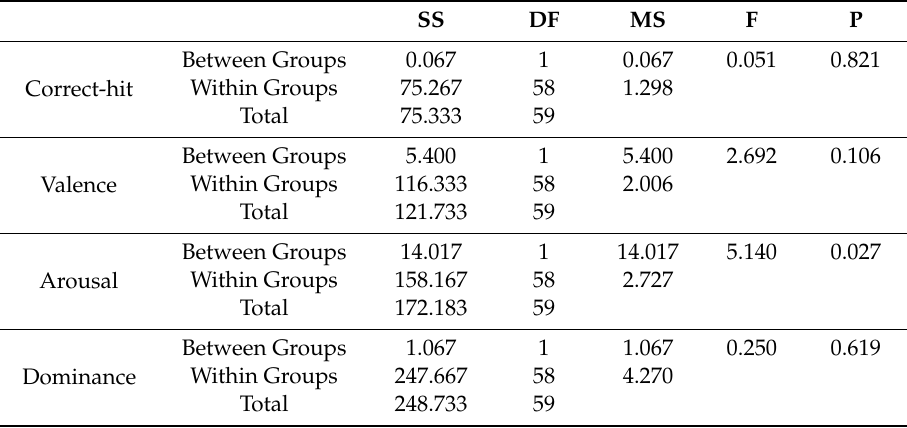
Table 7. ANOVA for the dirt-o ffl oading task with di ff erent feedbacks. SS DF MS F P Between Groups 0.067 1 0.067 0.051 0.821 Within Groups 75.267 58 1.298 Correct-hit 75.333 Between Groups 5.400 Valence Between Groups 14.017 1 14.017 0.027 Within Groups 158.167 58 2.727 Arousal 172.183 Between Dominance